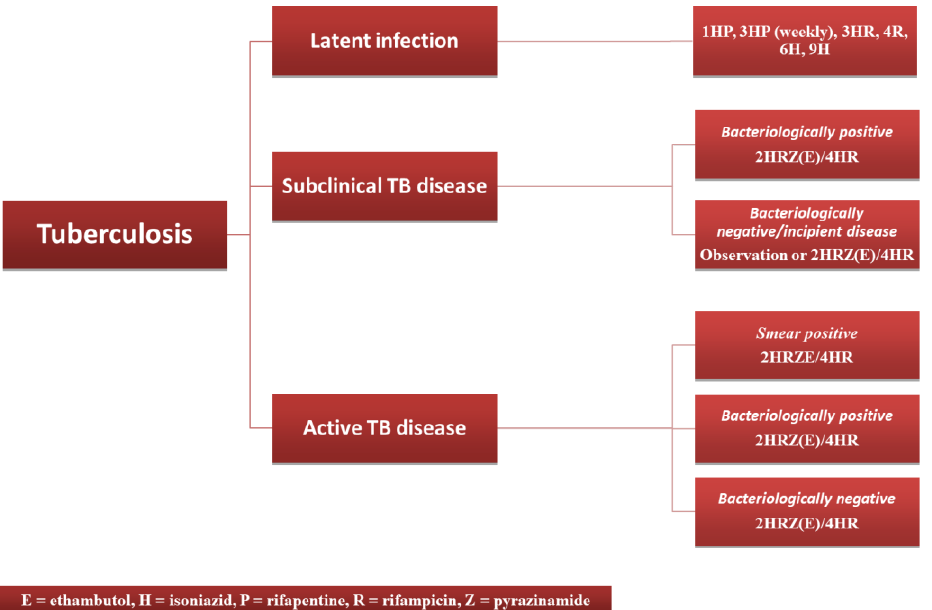
Figure 5. Therapeutic management of TB (adapted after [134]).